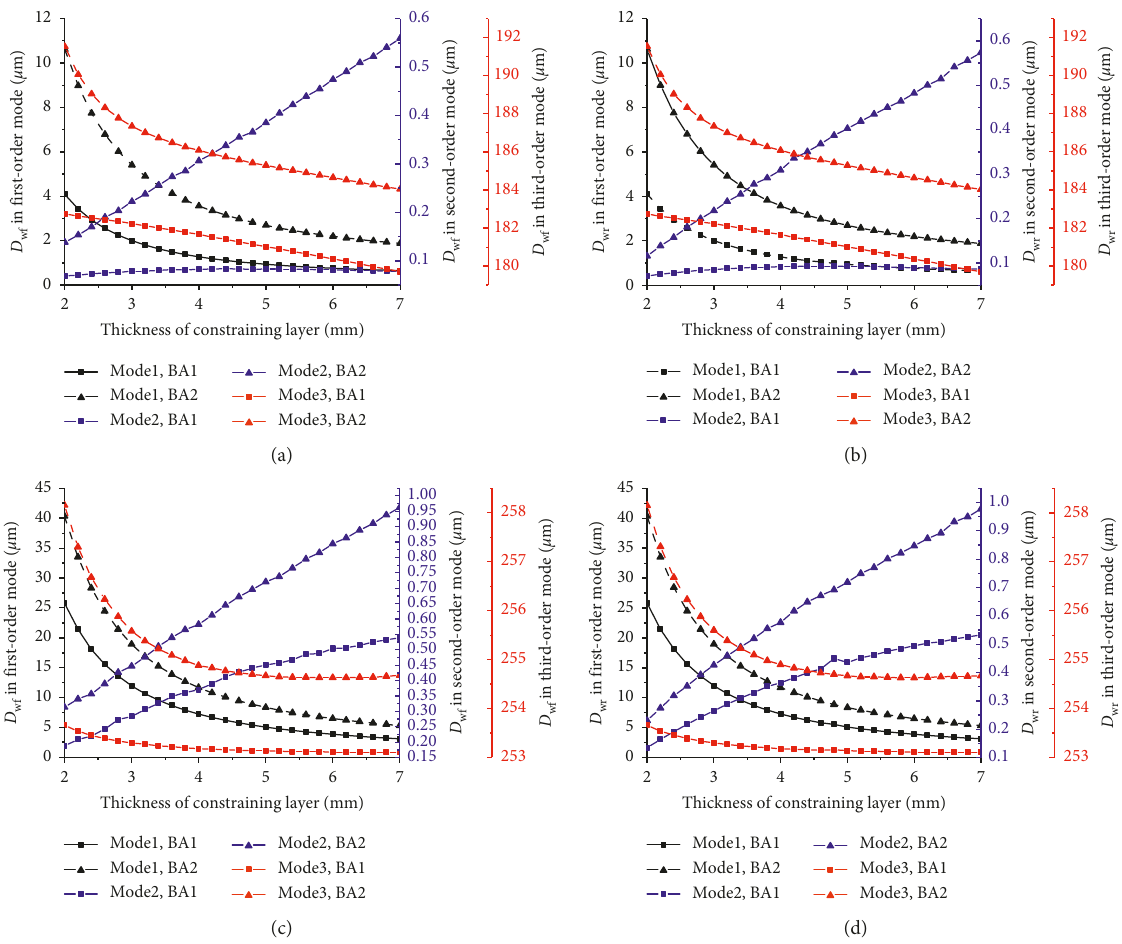
Figure 13: Displacement deviation between foundation and restraint layers in the position of the web plate. (a) Position I, upper constraining layer. (b) Position I, lower constraining layer. (c) Position II, upper constraining layer. (d) Position II, lower constraining